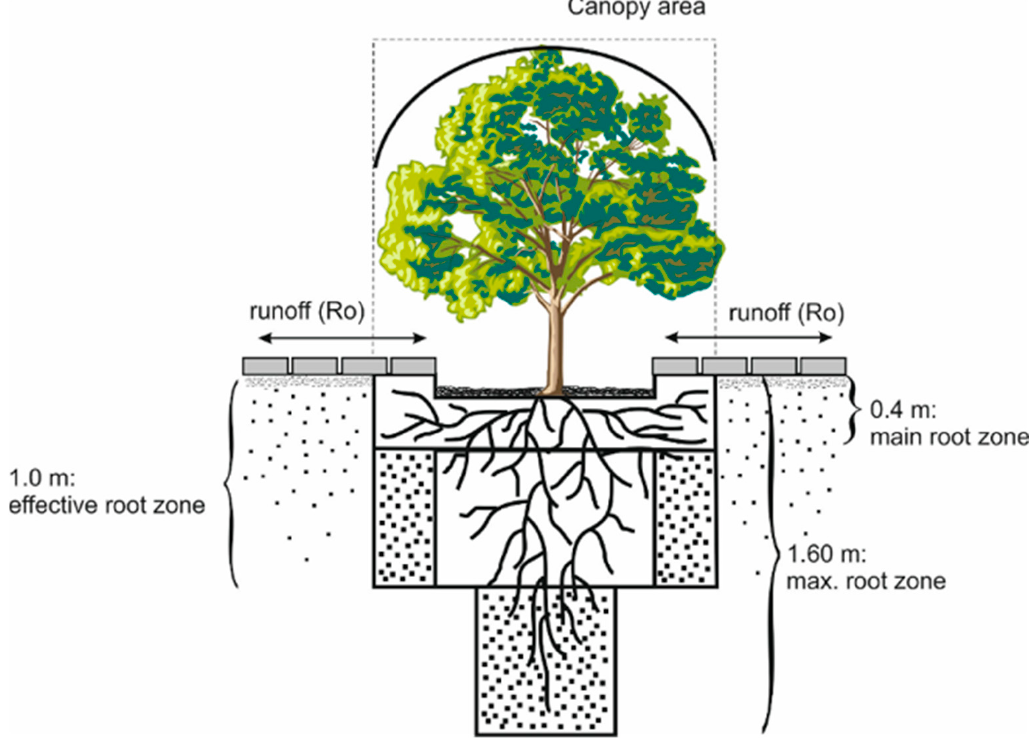
Figure 4. Scheme for characterizing the site conditions of a street tree.